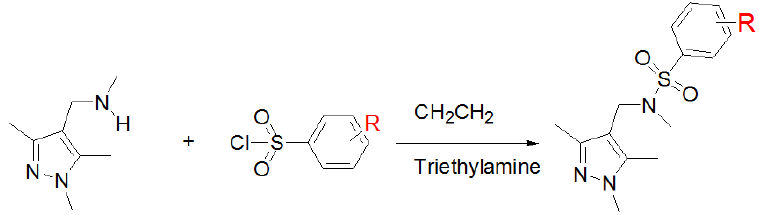
Scheme 1. General synthetic route for preparing the analogues of EH-1 . Table 1. The chemical structures of EH-1 and its Table 1. The chemical structures of EH-1 and its analogues. Table 1. The chemical structures of EH-1 and its analogues. Table 1. The chemical structures of EH-1 and its analogues. Table 1. The chemical structures of EH-1 and its analogues. Table 1. The chemical structures of EH-1 and its analogues. Table 1. The chemical structures of EH-1 and its analogues. Table 1. The chemical structures of EH-1 and its analogues. Table 1. The chemical structures of EH-1 and its analogues. Table 1. The chemical structures of EH-1 and its analogues. Table 1. The chemical structures of EH-1 and its analogues. Table 1. The chemical structures of EH-1 and its analogues.